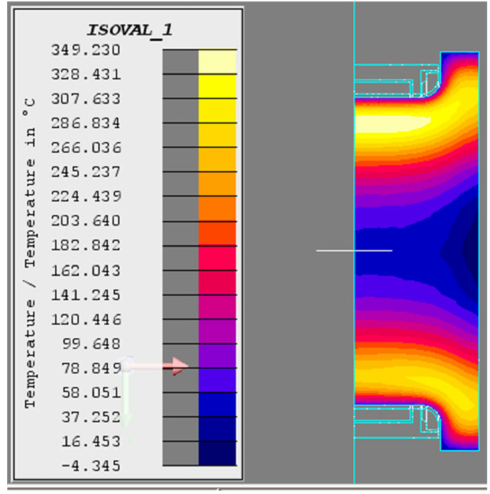
Figure 8. Temperature field of the crankshaft (T = 1 s).